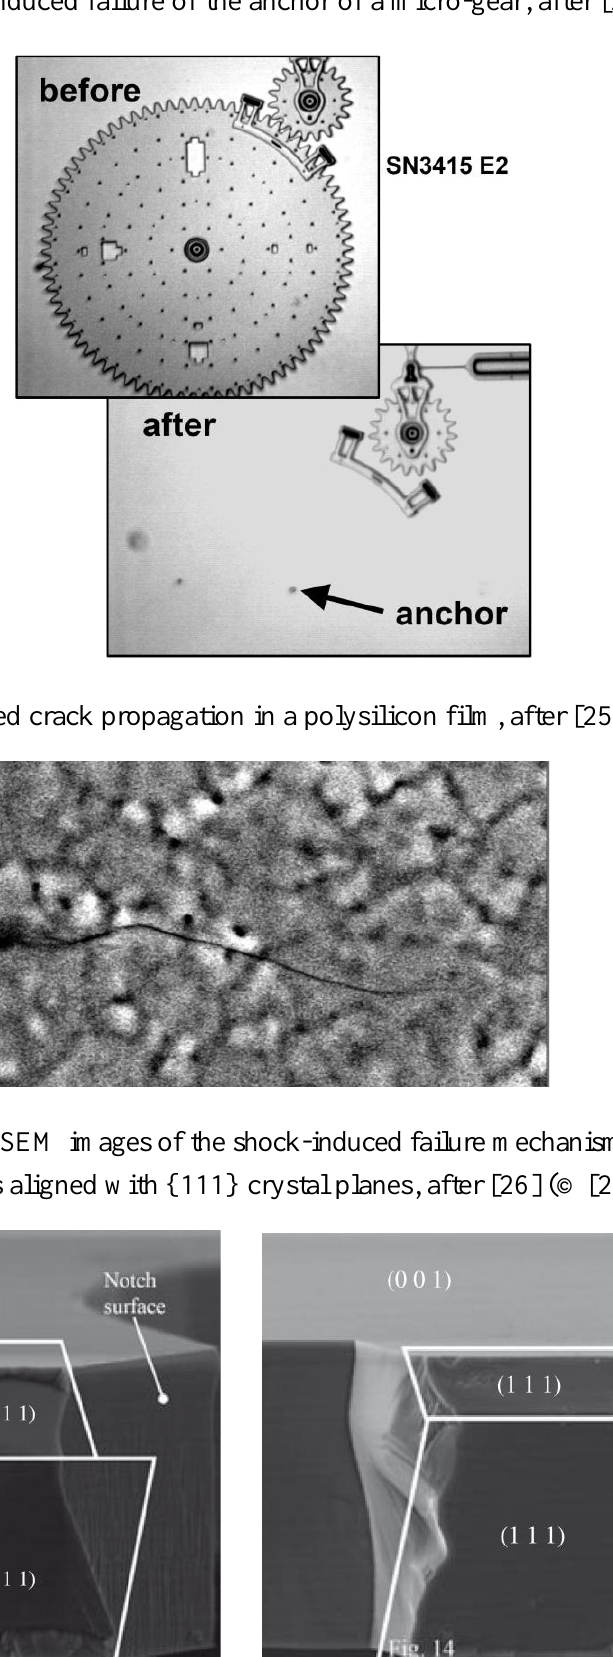
Figure 4. 20,000 g shock-induced failure of the anchor of a micro-gear, after [24] (© [2000] IEEE).